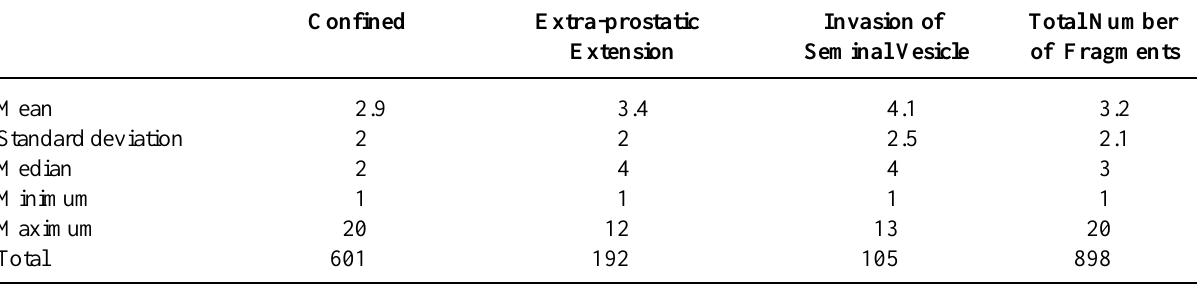
Table 6 – Descriptive measures for total number of fragments with cancer according to tumor